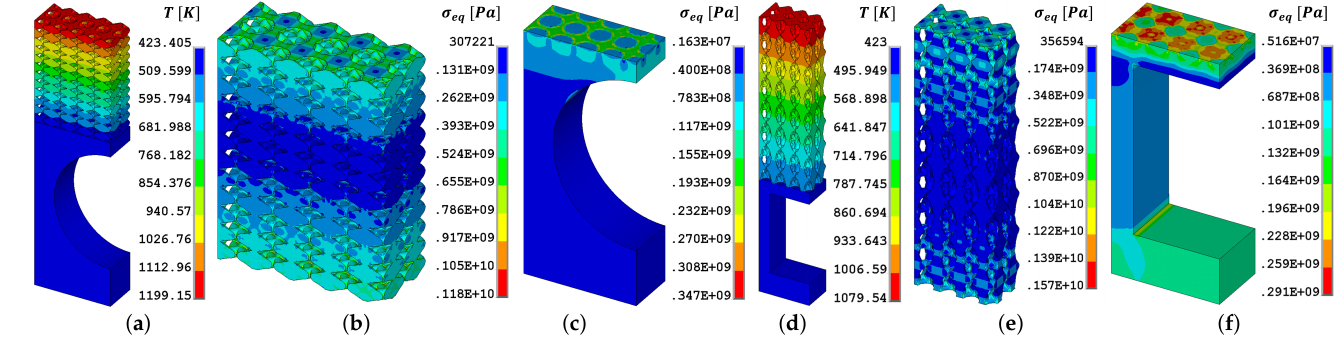
Figure 5. Contour plots of temperature and von Mises-equivalent stresses reached in armour and heat sink during normal reactor operation for ( a – c ) Configuration 1 and ( d – f ) Configuration